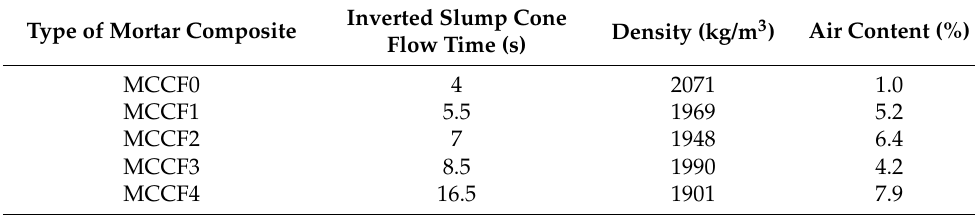
Table 2. Fresh properties of various mortar